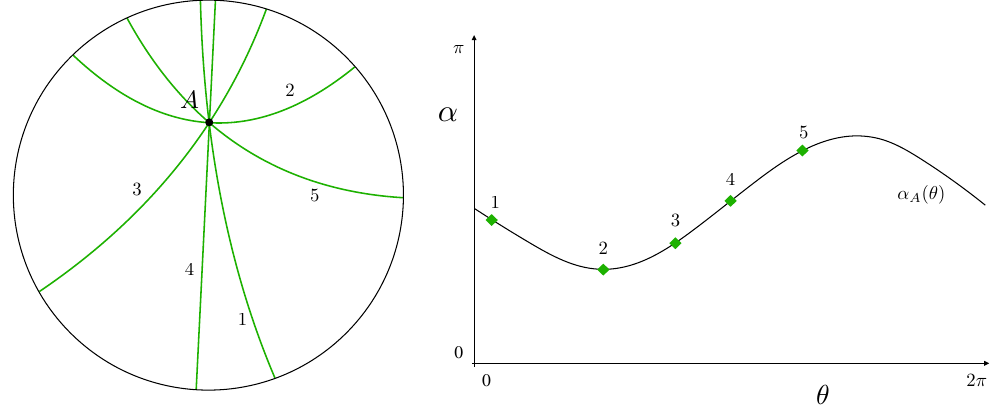
Figure 2 . Left diagram : a point A on a time slice of AdS, and five geodesics (in green) that intersect A . Right diagram: a point curve α A ( θ ) in kinematic space which represents all geodesics that pass through the bulk point A . The five diamonds (in green) on the point curve in the right diagram correspond to the five geodesics in the left